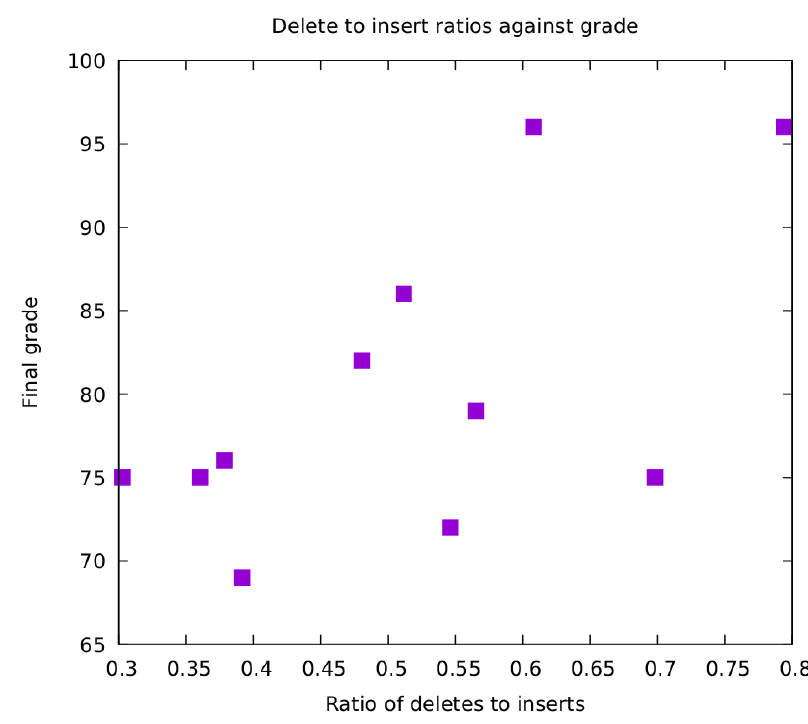
Fig. 9. Final grades achieved by students plotted against their ratio of deletion to insertion edits across all lessons. A value of 0.5 on the axis means there were twice as many insertions as deletions, a value of 1 on the x axis means there were the same number of insertions and